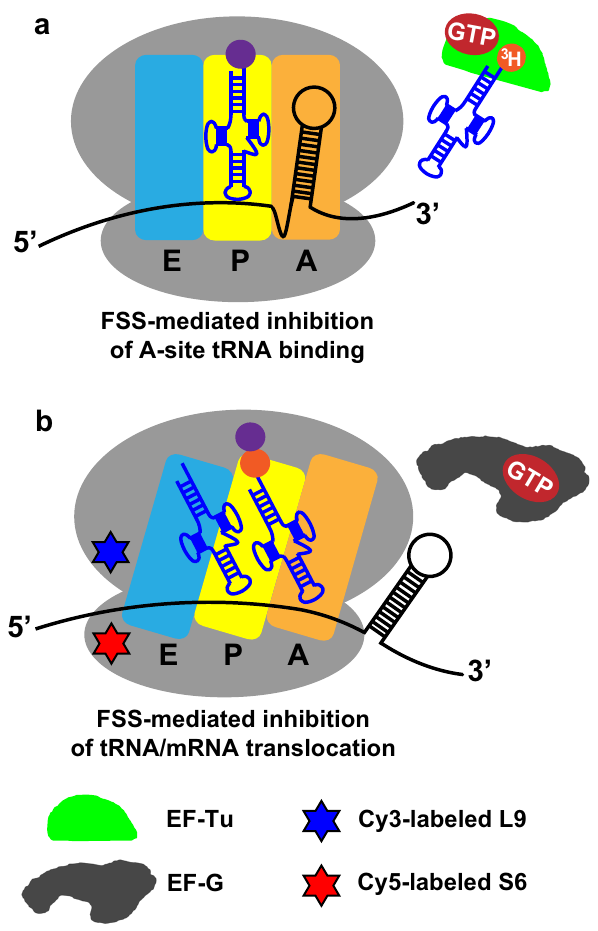
Fig. 2 Experimental design. a The effects of FSS variants on A-site tRNA binding were determined by fi lter-binding assays. 70S bacterial ribosome (gray) bound with P-site peptidyl-tRNA and mRNA was incubated with aminoacyl-tRNA, which had been charged with tritium-labeled amino acid and complexed with EF-Tu (cid:129) GTP. b The effects of FSS variants on ribosome translocation coupled to intersubunit rotation were studied by smFRET. Cy5 (red hexagram) and cy3 (blue hexagram) fl uorophores were attached to the 30S protein S6 and 50S protein L9, respectively. The pre-translocation S6-cy5/L9-cy3-labeled ribosome contained deacylated and peptidyl-tRNAs that adoped P/E and A/P hybrid states in the R conformation of the ribosome. EF-G (cid:129) GTP was delivered to the ribosome by injection. The amino acids bonded with cognate tRNAs are shown in purple and orange. A, P and E sites of the ribosome are indicated by orange, yellow, and blue,